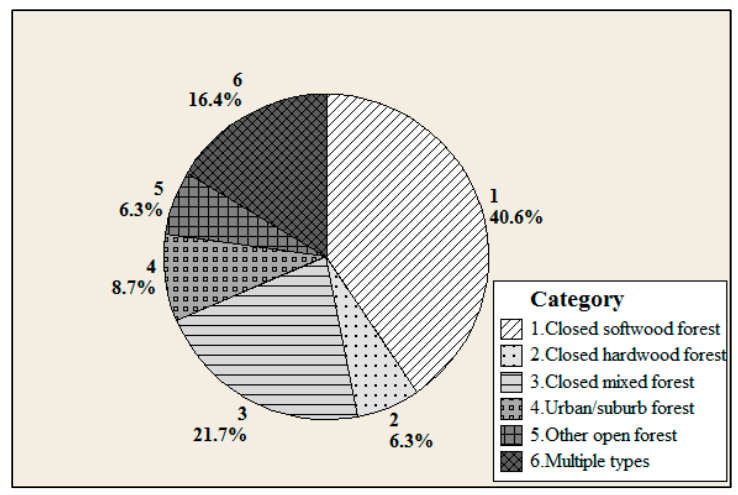
Figure 5. Summary of forest types in ITCD and related research ( N = 207).